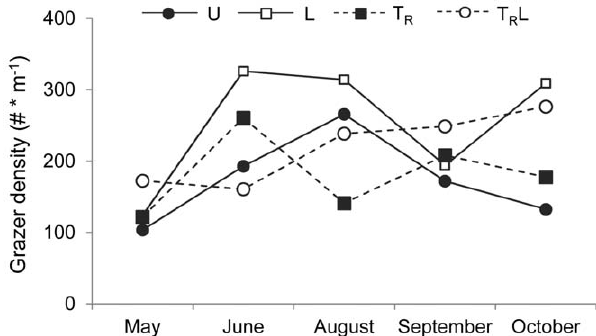
Figure 6. Grazer density. Grazer density (mean number 6 SE per m 2 ) over the whole season in unmanipulated (U), light (L), terrestrial invertebrate reduction (T R ), terrestrial invertebrate reduction 6 light (T R L) treatments. Error bars have been omitted for clarity.